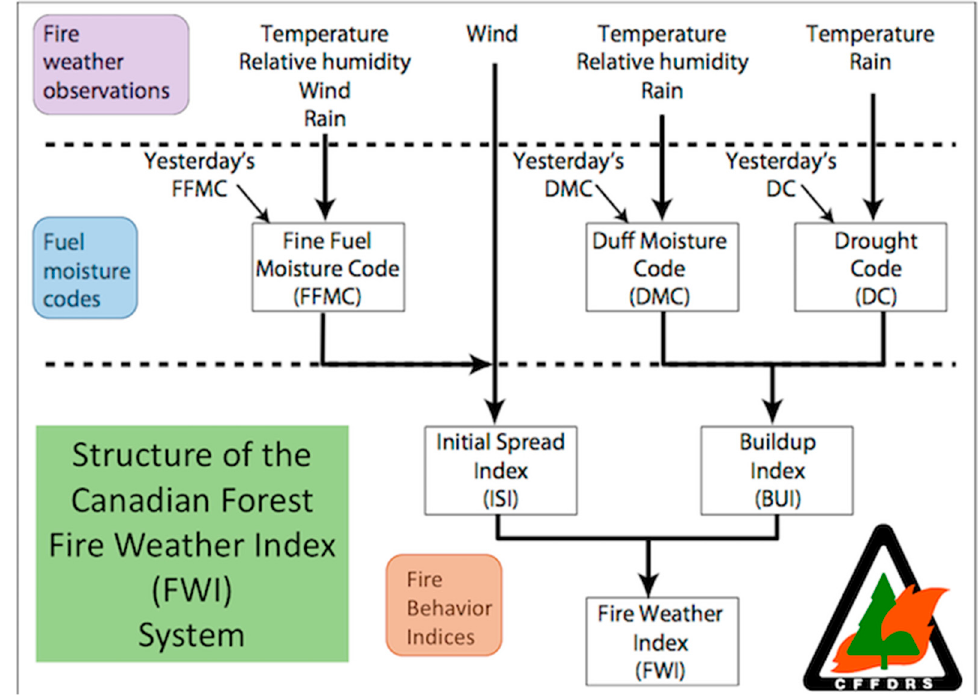
Figure A4. Fire weather index calculation scheme [23] and DC computation code.